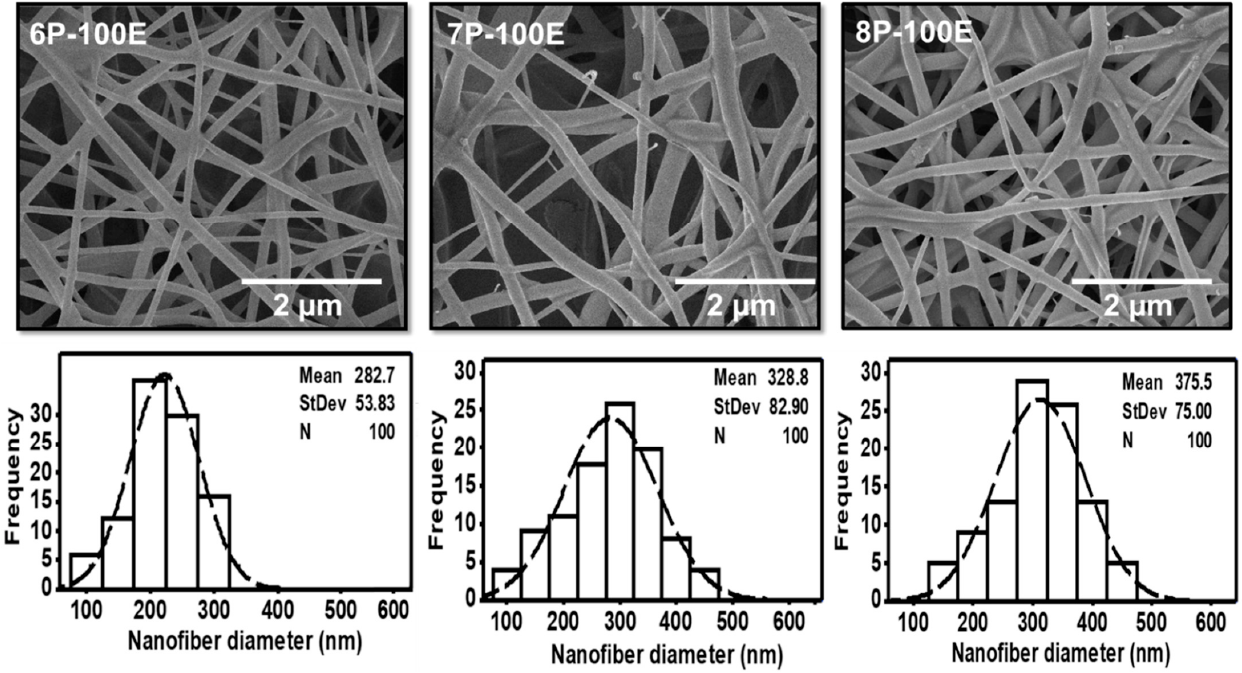
Figure 2. SEM images and histogram of diameter distribution of the developed electrospun nanofibers at 6, 7, and 8 wt/wt% of PVA, while using the 100% AI extract as solvent. Figure 3 indicates the influence of the AI extract on the diameter of the PVA nano- fibers at different AI /water ratios of 50:50, 75:25, and 100:0, whereas the PVA concentration is kept constant at 8 wt. The mean diameter is noted as 384 ± 83, 380 ± 76, and 376 ± 75, respectively, for the AI /water ratio 50:50, 75:25, and 100:0. The histogram of all the samples with different AI /water ratio reveals the uniform nanofiber diameter distribution. Hence, the impact of the AI /Water ratio on the nanofiber diameter is not as significant as PVA concentration, and no defined relation is noted between AI /Water ratio and nanofiber di- ameter.